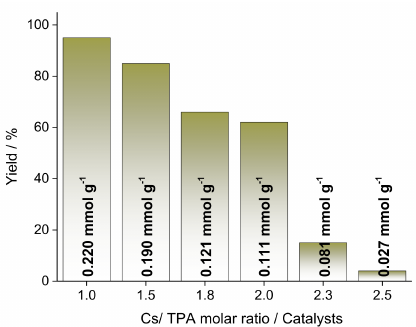
Figure 30. Yield of methyl oleate in the oleic acid esterification with methanol over different catalysts. The catalysts, in the graph, are represented by the Cs/TPA molar ratio from 1.0 to 2.5. Inside the bars, the acid site concentration of each catalyst is shown. Reaction conditions: molar ratio methanol:oleic acid (20:1), catalyst (15 wt%), temperature (65 ◦ C), time (8 h) (adapted from